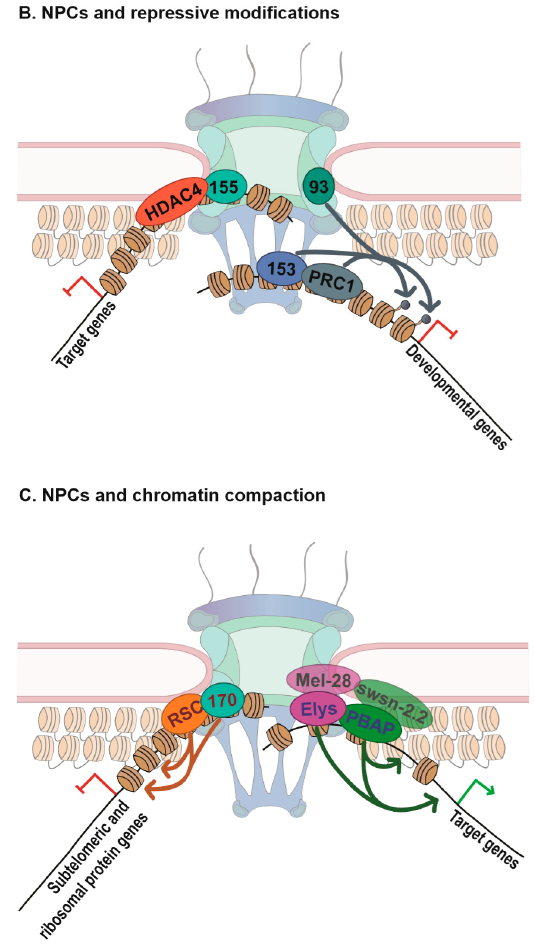
Figure 1. Nuclear pore complexes (NPCs) and Regulation of Chromatin States. ( A ) NPCs and active histone modifications. Mammalian and yeast Nup98 / Nup100 have been shown to regulate binding of HMT complex Set1 / COMPASS to chromatin, and influence deposition of downstream active chromatin marks H3K4me2 / 3 [14,22]. Association of Drosophila Nup98 and the related H3K4me2 HMT Trx